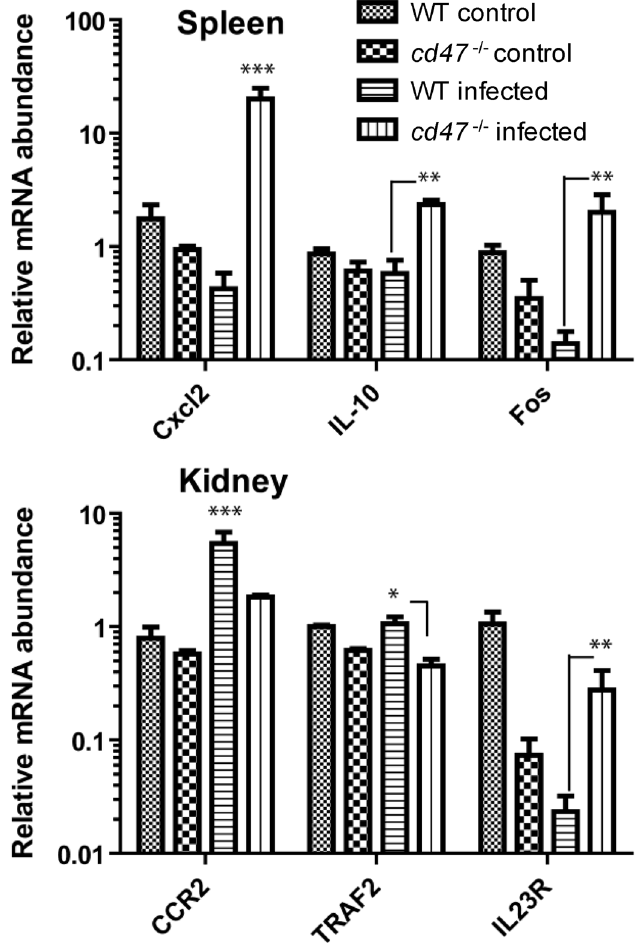
Fig 7. Effect of CD47 on inflammatory gene expression induced by candidemia. mRNA abundance was determined by qPCR using cDNA synthesized from total RNA of spleens and kidneys. Uninfected WT and cd47 -/- mice were compared with the infected WT and cd47 -/- mice. Each group had at least three mice. Cxcl2, IL-10 and Fos expression in spleens were significantly up-regulated in infected CD47 mice compared with the WT infected mice (p > 0.001, .01 and 0.01 respectively). CCR2 and TRAF 2 of infected cd47 -/- kidney tissues were significantly down-regulated compared with the infected WT mice, while IL23R was significantly up regulated in infected cd47 -/- mice (p > 0.001, 0.05 and 0.01 respectively). Results from three mice per group were analyzed using two-way ANOVA with post Bonferroni comparison